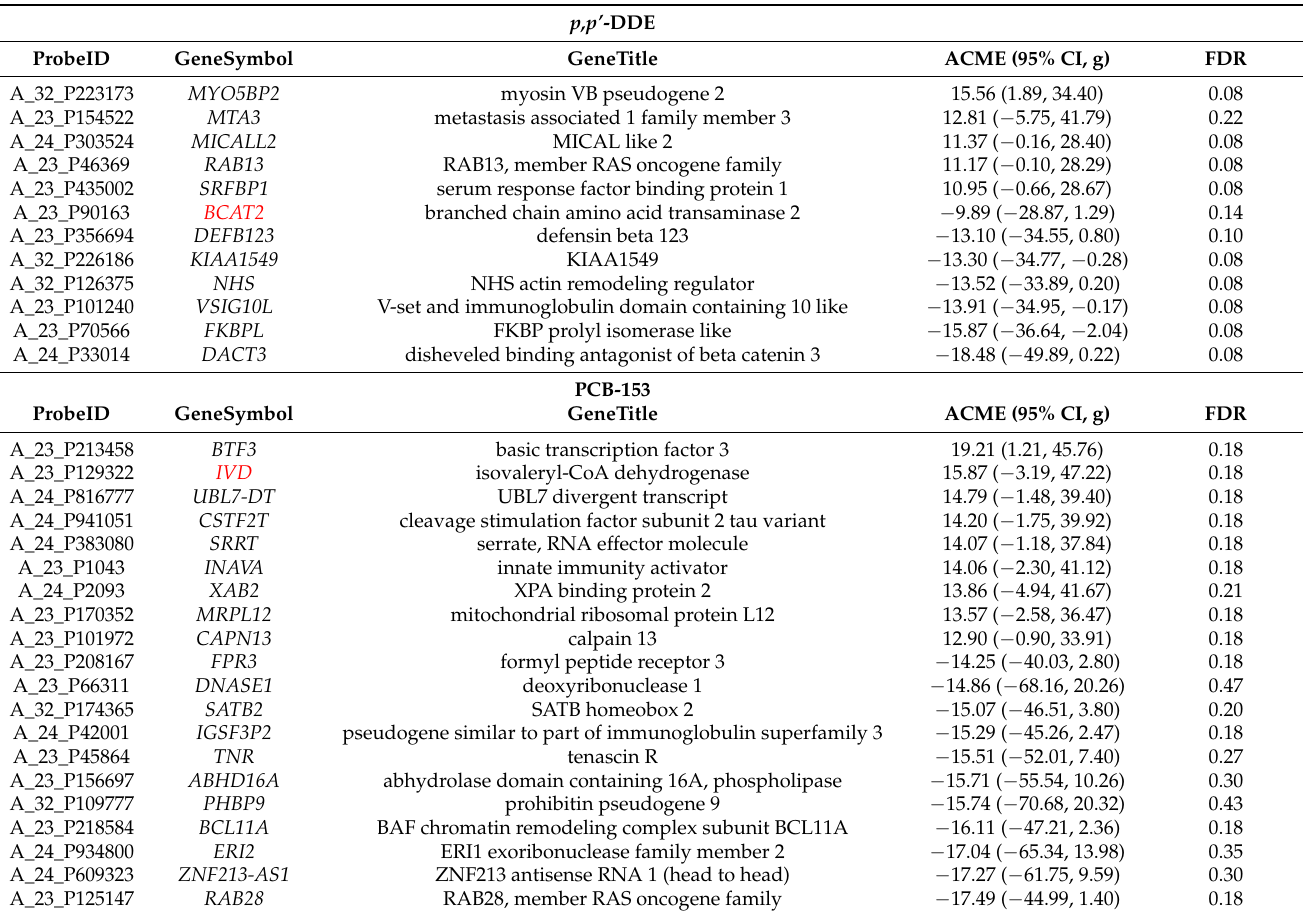
Figure 1. Venn diagram of features and enriched pathways associated with MDCs and birth weight. Number in black refers to the number of features at p -value < 0.05, and number in white refers to the number of enriched pathways at FDR < 0.05. Table 3. The ACMEs of an MDC on birth weight via overlapping gene